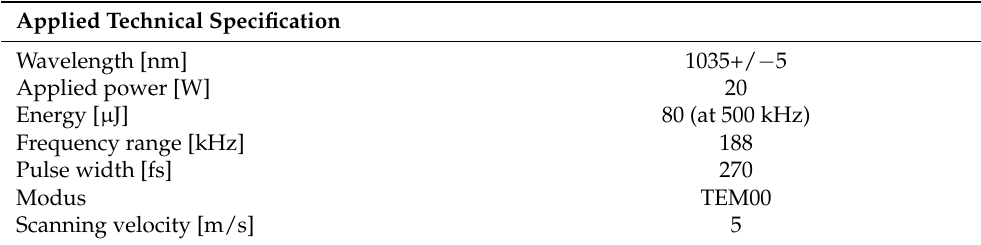
Table 1. The used technical parameters of the Monaco 1035-80-40 femtosecond laser. Applied Technical